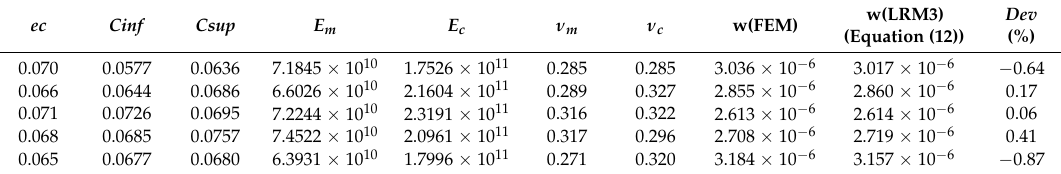
Table 13. Verification of statistic model LRM3 (case study 2, thinner core).